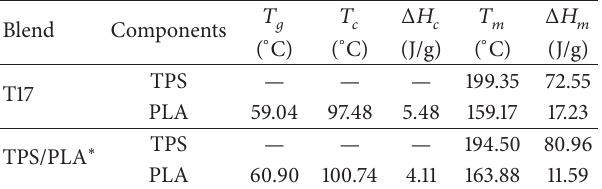
Table 3: Phase transitions of the flexible